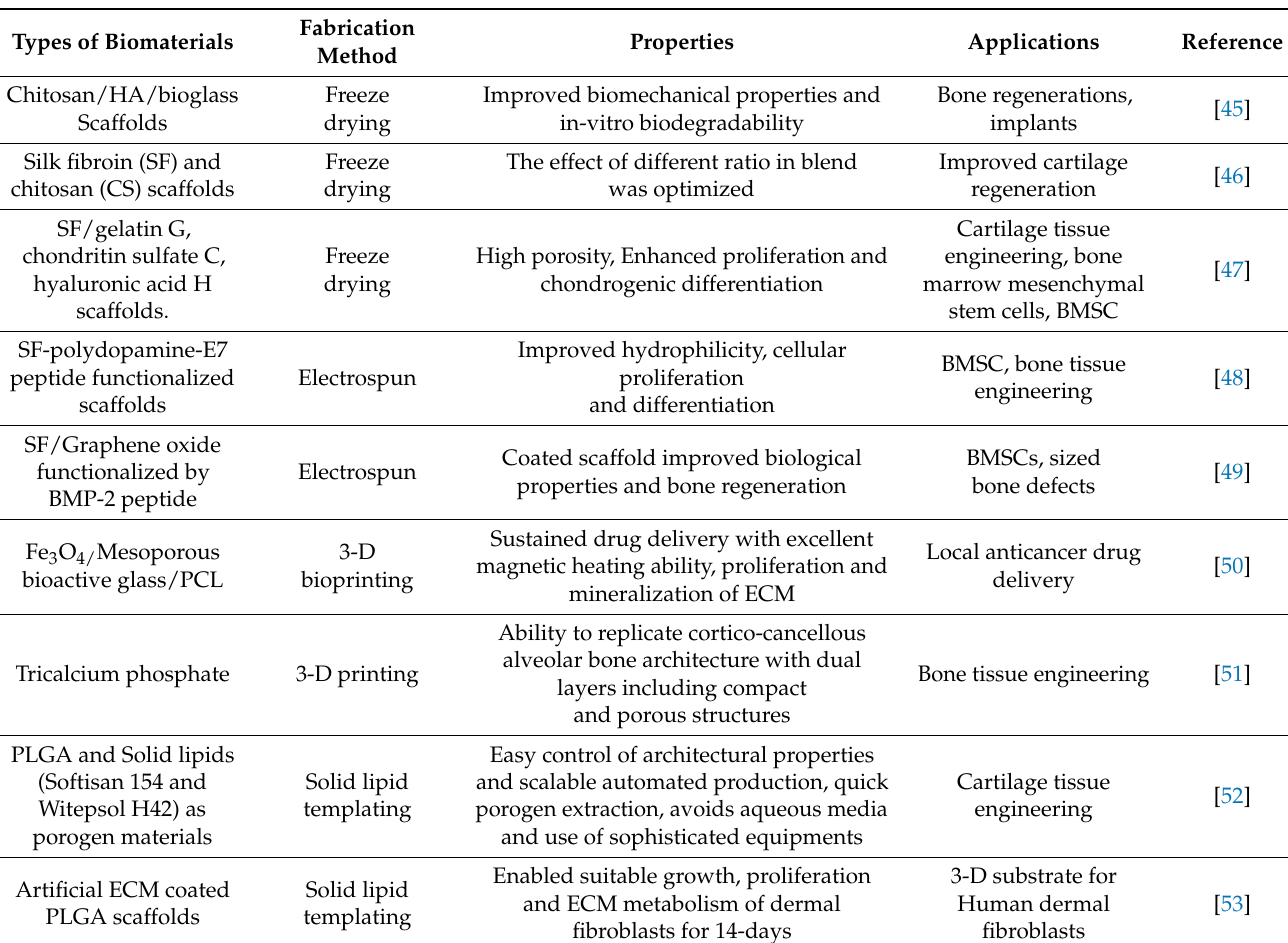
Table 1. Current state of materials and fabrication technologies for tissue